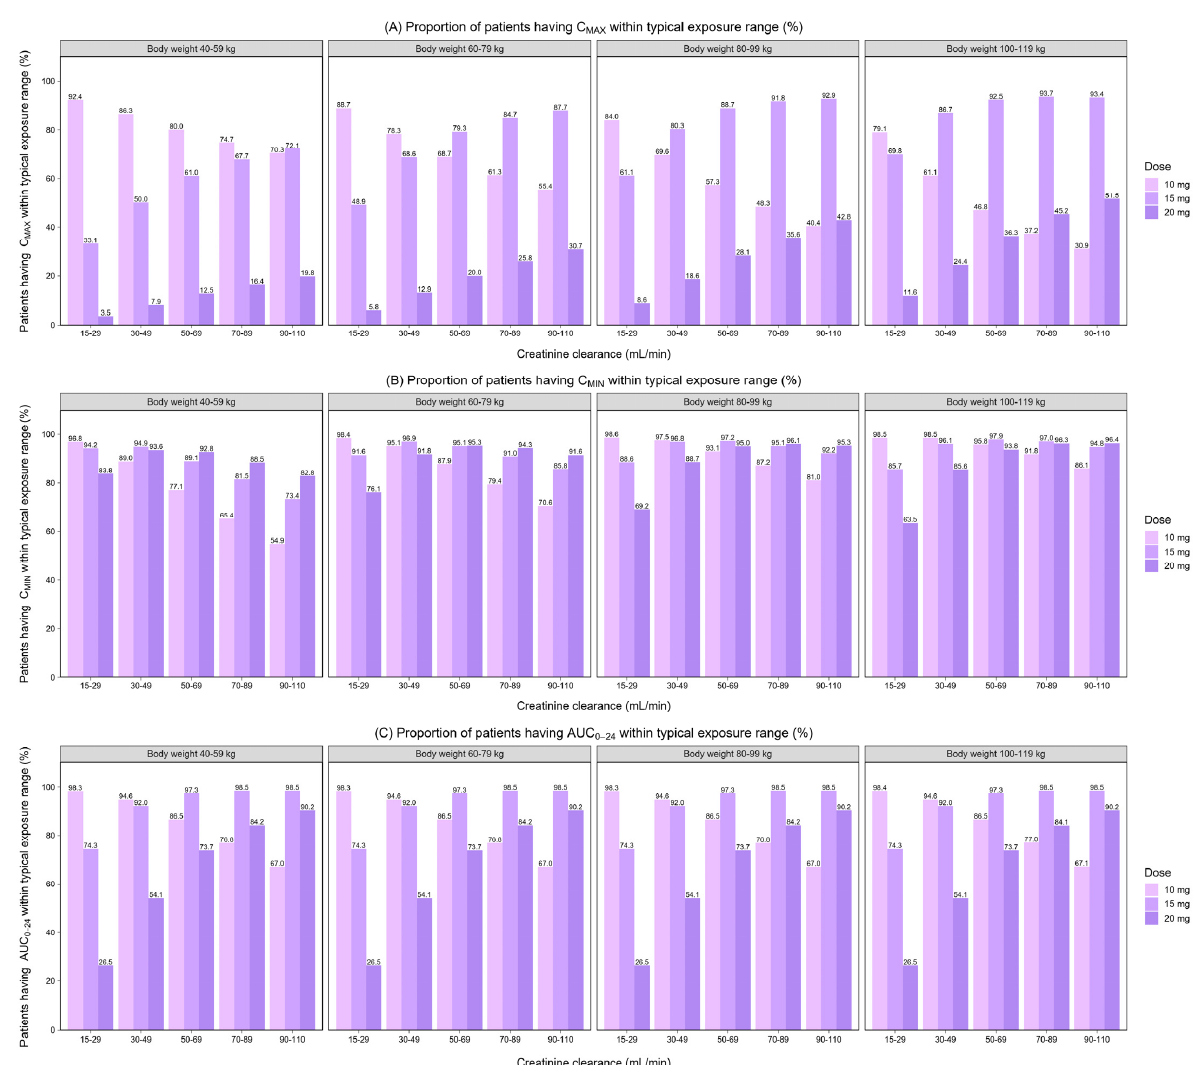
Figure 5. Simulated AUC 0–24 of rivaroxaban with different dosing regimens. The solid black lines represent the median AUC 0–24 The shaded areas represent the 90% prediction interval of the model. The dashed lines represent the 5th and 95th percentile ranges of the typical AUC 0–24 (1860–5434 ng·h/mL) reported in patients with non-valvular atrial fibrillation receiving 20 mg of rivaroxaban [19].